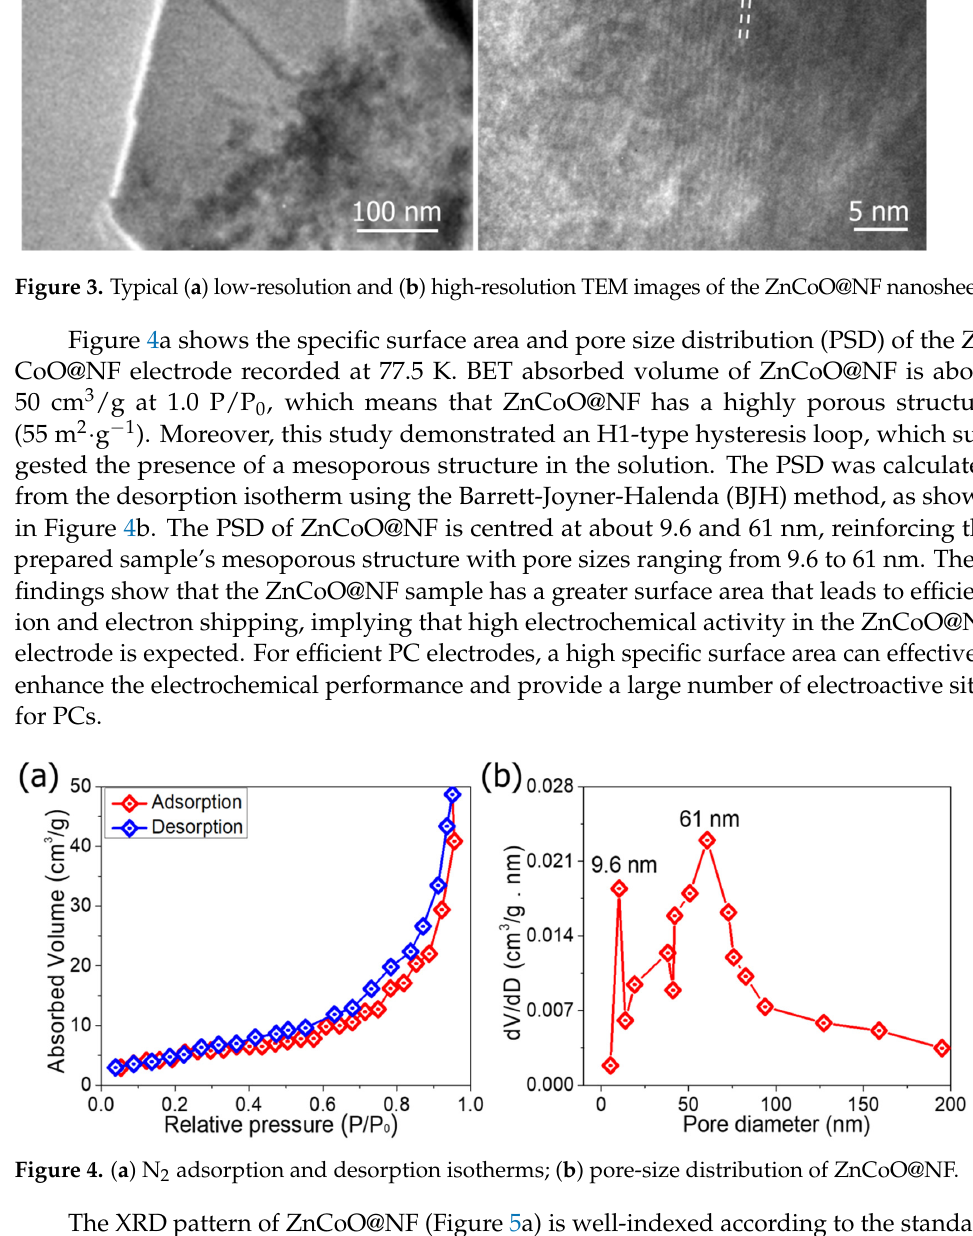
Figure 2. The SEM images of ZnCoO@NF at different magnifications: ( a ) low, ( b ) medium, and ( c ) high.